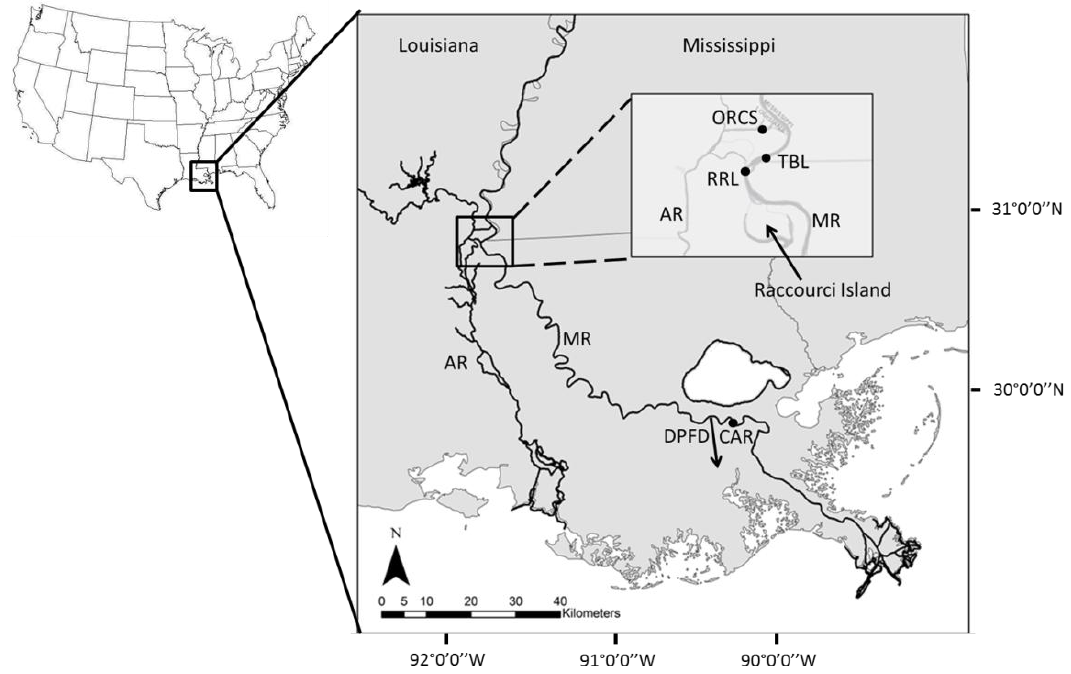
Figure 1. Lower Mississippi River (MR) with the locations of Old River Control Structure (ORCS) where approximately 25% of the Mississippi River’s water is diverted into the Atchafalaya River (AR); Tarbert Landing (TBL) where long-term discharge and suspended sediment records are collected for this study; Red River Landing (RRL) and Carrolton, New Orleans (CAR) where river stage data are used for this study; and Davis Pond Freshwater Diversion